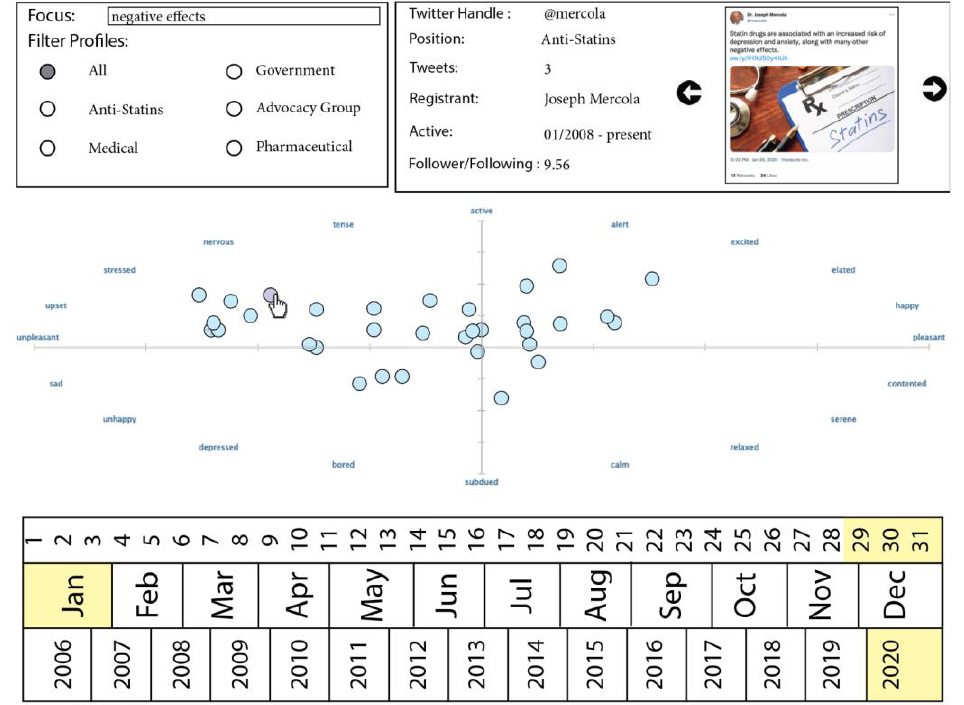
Figure 12. VAS for